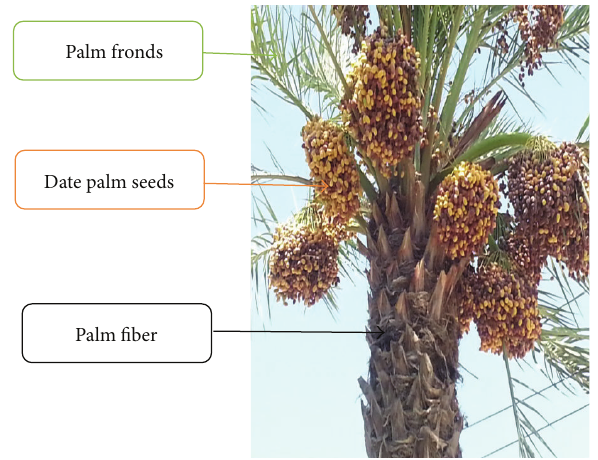
Figure 1: Diagrammatic representation of Iraqi Khestawy date palm